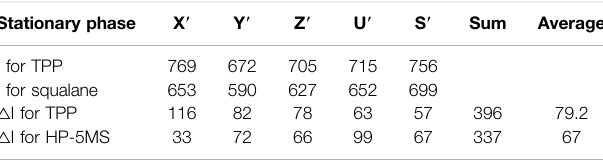
TABLE 2 | McReynolds constants of the TPP and HP-5MS columns. Stationary phase